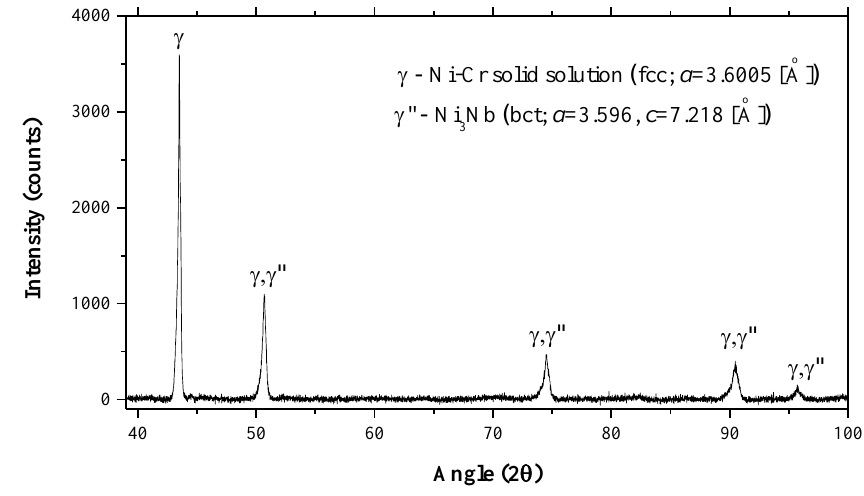
Figure 6. X-ray diffractometer (XRD) spectrum for the IN718 powder sample.